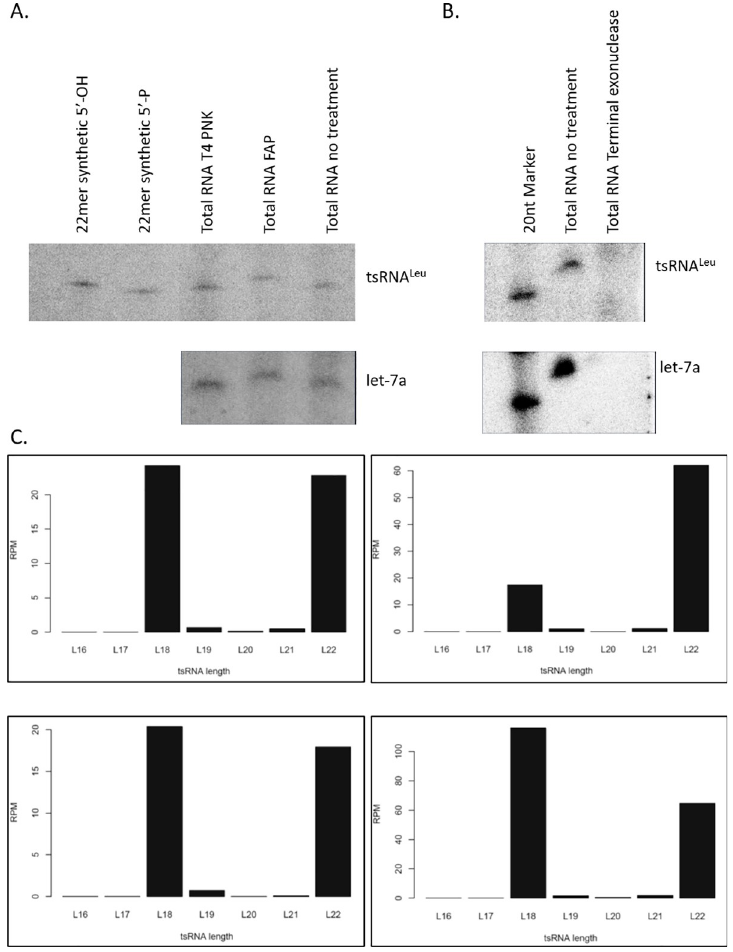
Fig 5. 5´ terminal 3´ tsRNA Leu is phosphorylated. (A) HeLa total RNA was treated with T4 PNK or FAP and northern blots were performed. Nontreated RNA sample, synthetic 22mer tsRNA Leu with either a 5´-hydroxyl